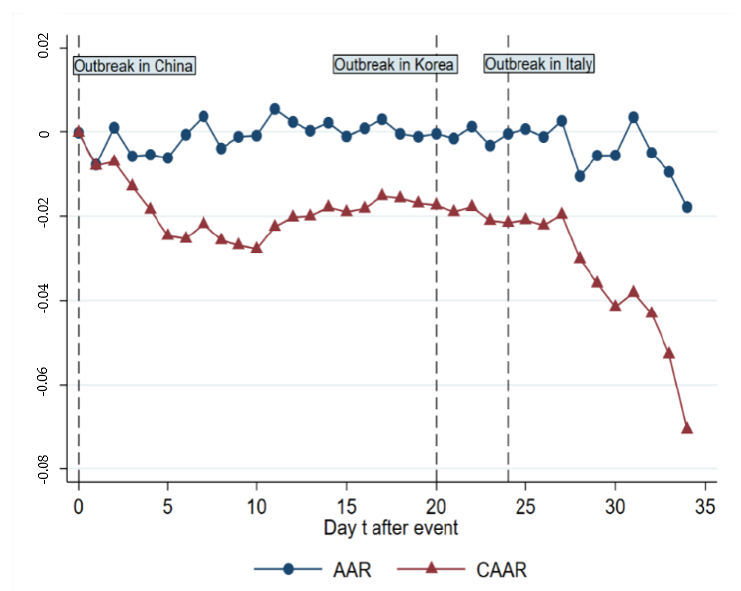
Figure 6. Average abnormal return (AAR) and cumulative average abnormal return (CAAR) change from day 0 to 34.